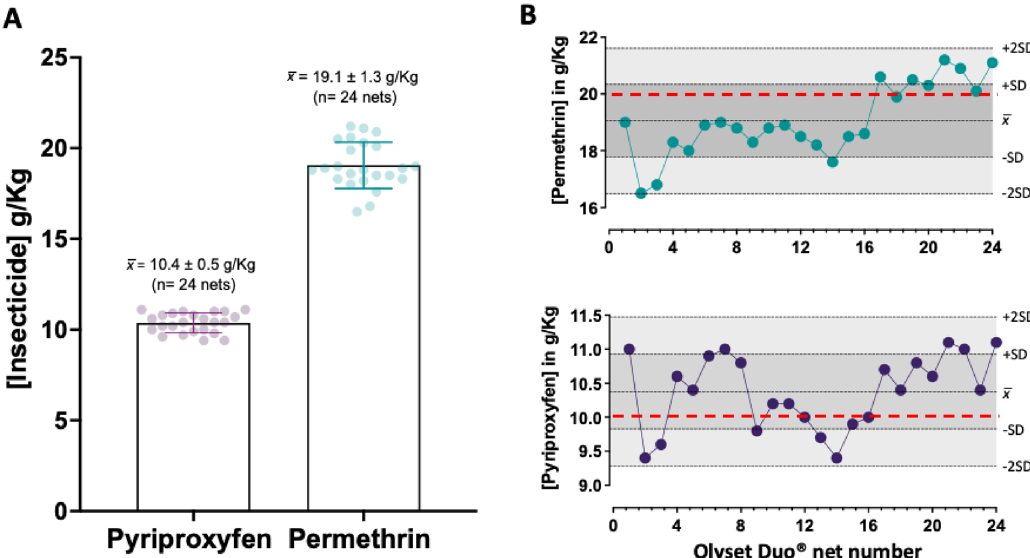
Figure 6. Analysis of total pyriproxyfen and permethrin content in Olyset® Duo LLIN. ( A ) The optimised method analysed the average content of pyriproxyfen and permethrin ± standard deviation (SD) for 24 Olyset® Duo. ( B ) Levy-Jenning’s chart for the 24 nets analyzed in triplicates (n = 72 samples) by the optimized method. Pyriproxyfen (top chart) and permethrin (bottom chart) scored an average (x ̄ ) of 10 ± 0.5 and 19.1 ± 1.3 g/kg, respectively. Reference concentrations for both active ingredients declared by the manufacture are denoted as red dotted lines on the charts.